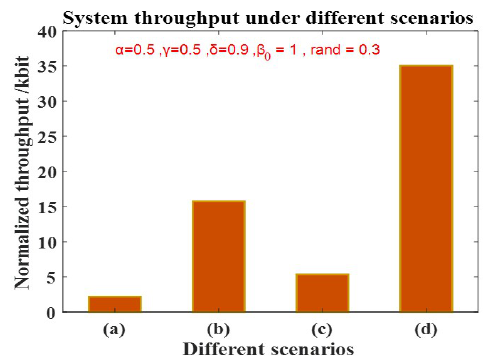
Figure 8. Normalized throughput for different scenarios. (a) Single-satellite single-beam multi-user. (b) Single-satellite multi-beam multi-user. (c) Multi-satellite single-beam multi-user. (d) Multi-satellite multi-beam